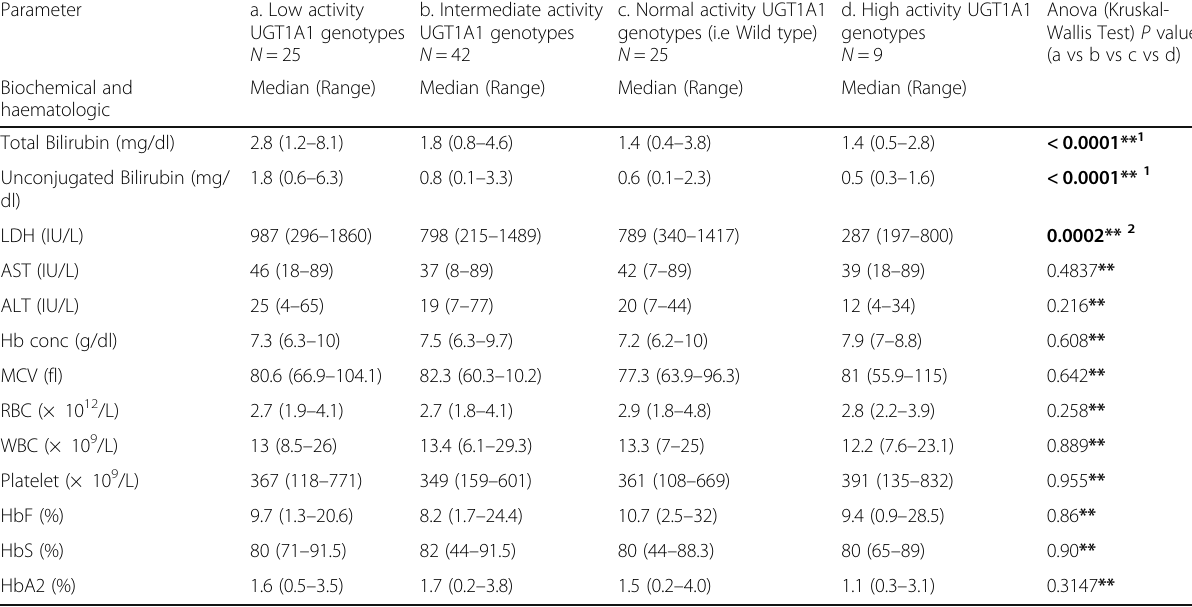
Table 2 Influence of UGT1A1 (TA) n genotype on laboratory parameters of patients Parameter